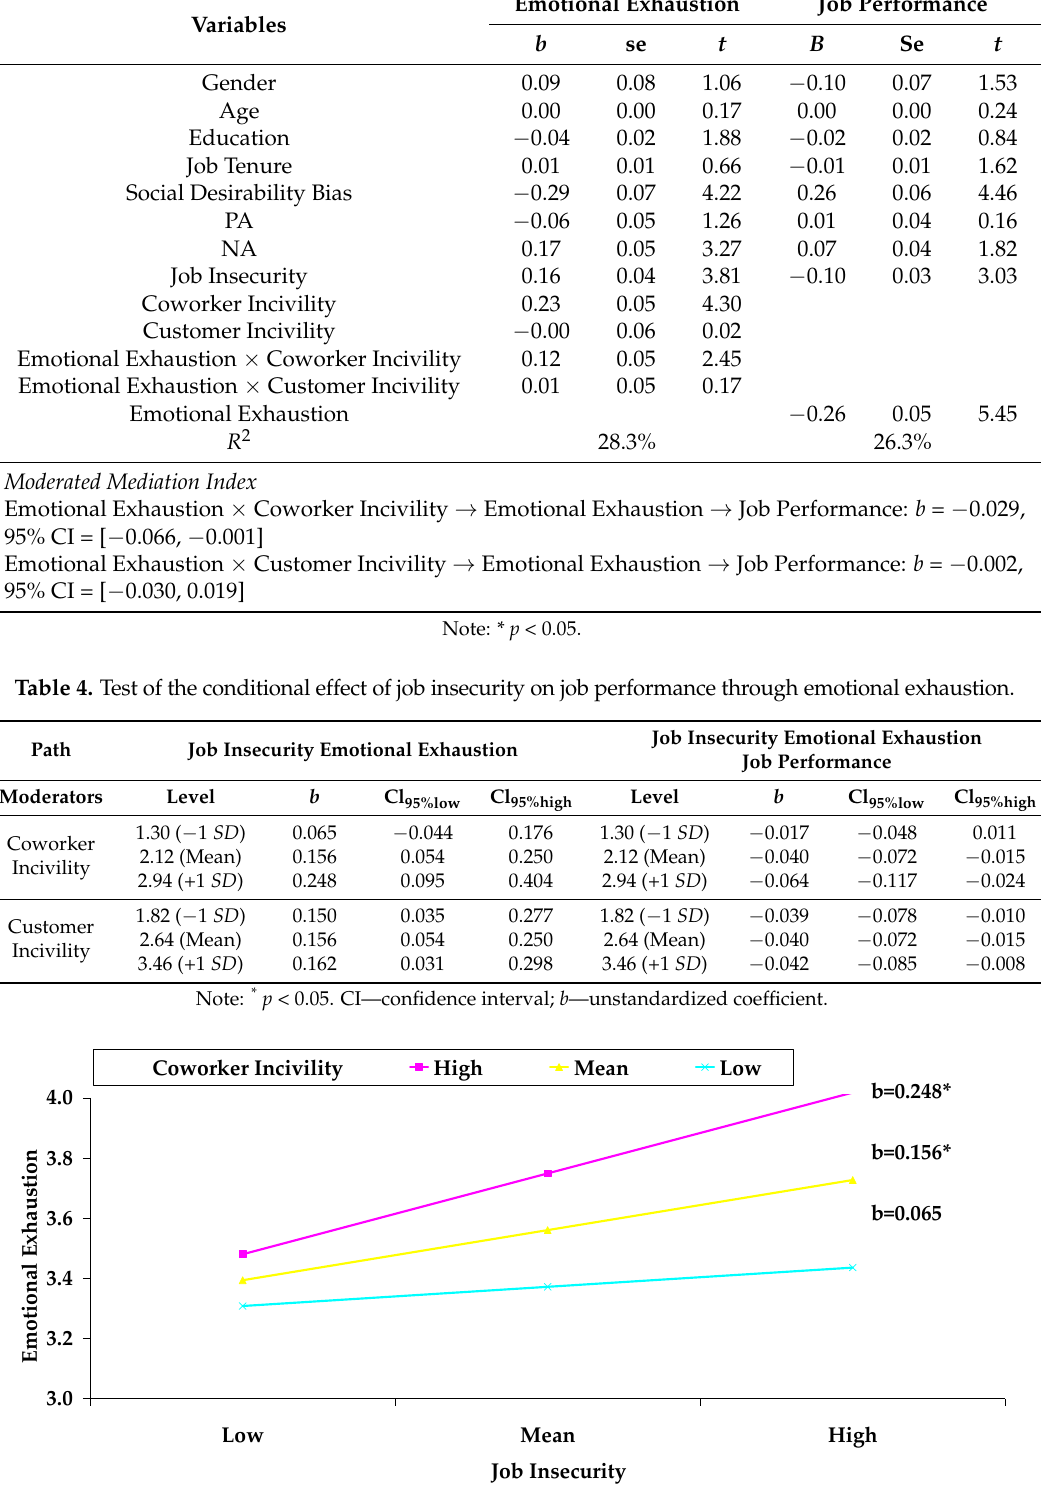
Table 3. Test of the moderating effects of coworker and customer incivility. Variables